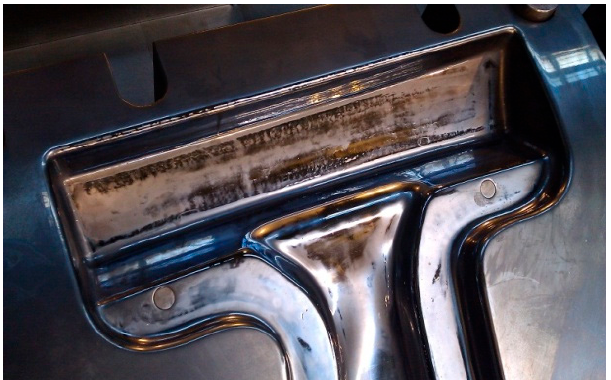
Figure 1. Example of tool wear occurrence in the sheet metal forming of the B-pillar part using DP980 steel sheets [3].